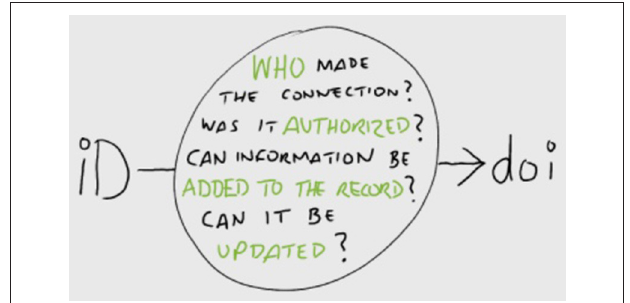
FIGURE 1 | Assertion information enables traceability. From Brown